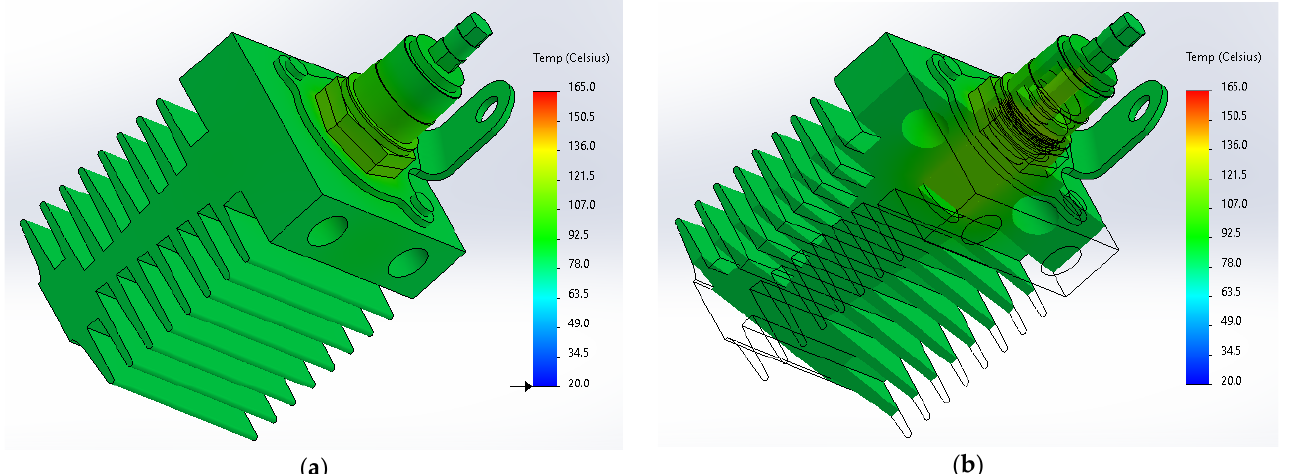
Figure 14. The simulation result showing the heat sink for a power of Pj = 49.61 W: ( a ) side view; ( b ) cross section. The temperature ranges from 20 °C to 165 °C.